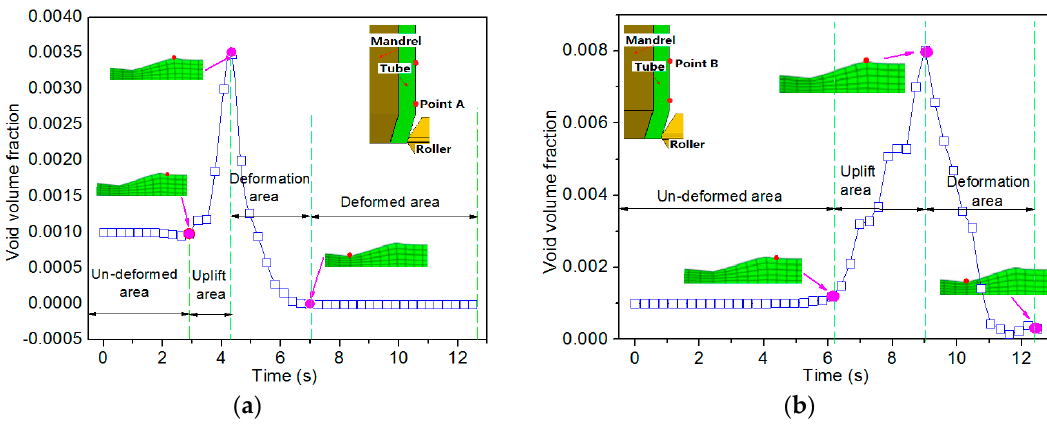
Figure 9. Distribution of void volume fraction (VVF) of the point ( a ) without crack and ( b ) with crack in forward tube spinning.